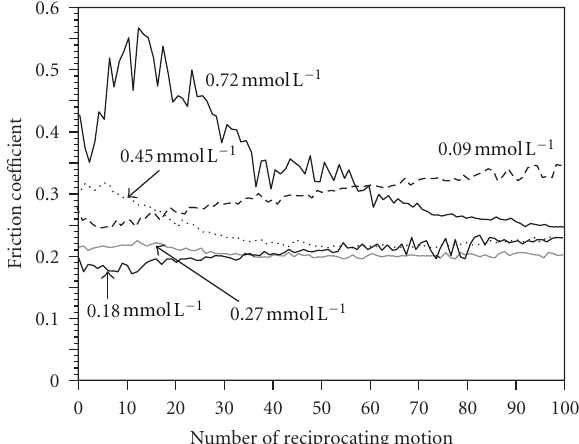
Figure 13: Concentration e ff ect on friction of the lubricant solu-